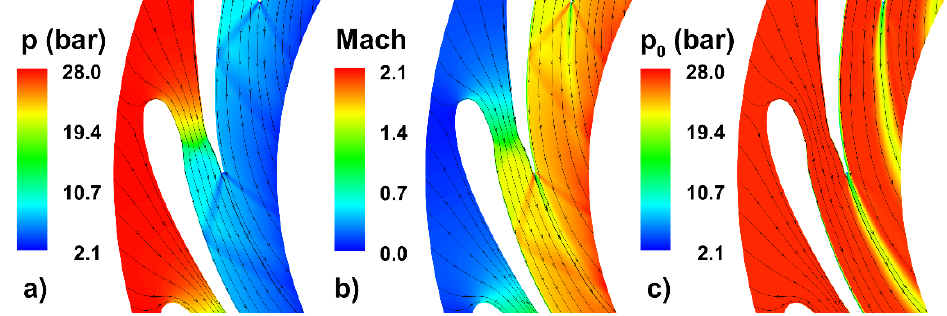
Figure 6. 15 vanes–75° outlet metal angle mid-span distributions: ( a ) static pressure; ( b ) Mach number; ( c ) total pressure.